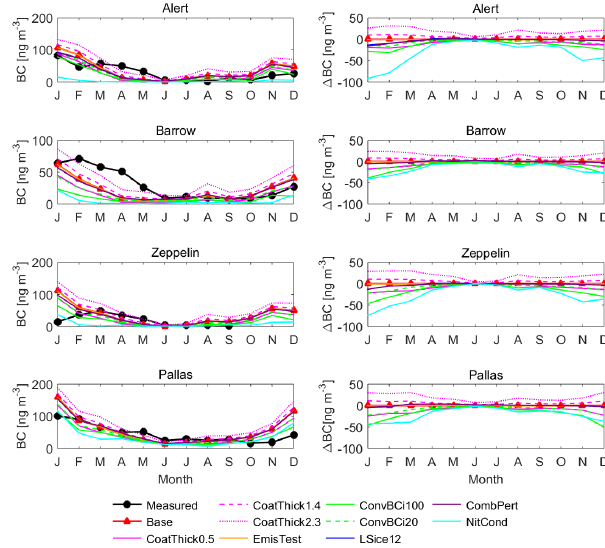
Figure 4. Monthly surface concentrations of BC at Arctic stations in 2008: (right) measurements versus baseline and sensitivity ex- periments and (left) difference between each sensitivity experiment and the